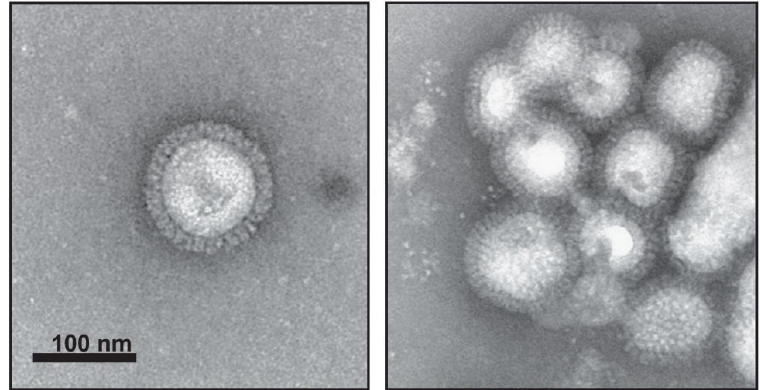
Figure 2. Electron microscopy images of influenza VLPs prepared in Sf9 cells using baculovirus expression system. Recombinant VLPs contain three subtypes (H5, H7, H9), morphologically and biochemically are similar to the wild type influenza virus, and can be found as individual particles (left) or groups of particles (right). Characterization of triple-subtype VLPs was done by negative staining transmission electron microscopy. (Adapted from [50], Copyright 2013, with permission from Elsevier,